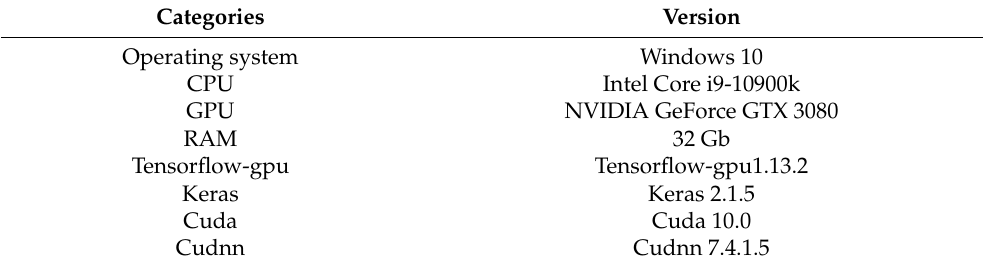
Table 1. Experimental